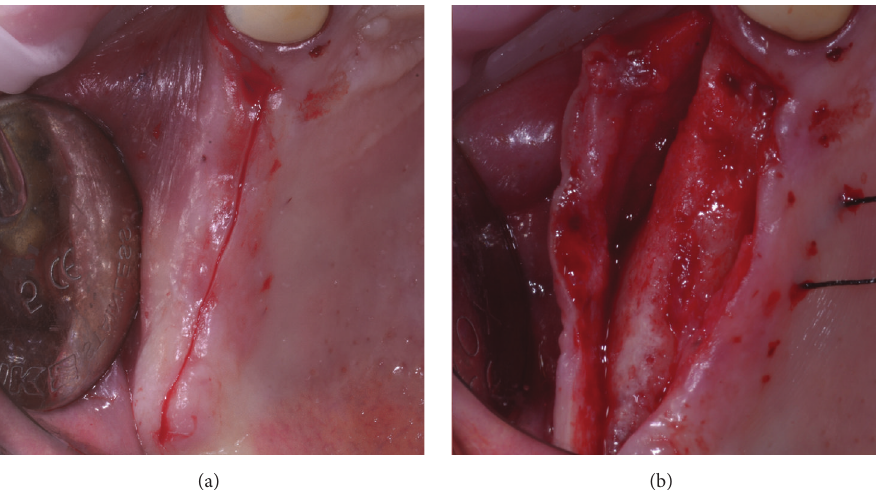
Figure 8: A single incision is performed on the medial, occlusal line of the ridge, preserving the papilla of the most distal residual element